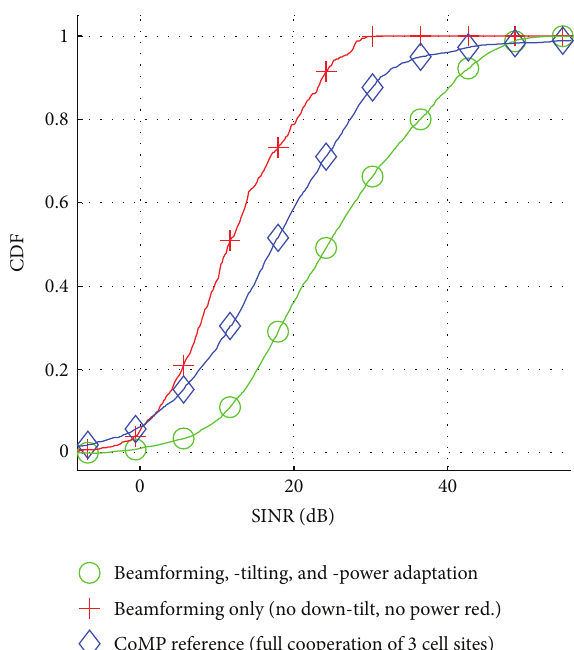
Figure 11: The blue line (diamonds) is the reference scenario as in Figure 5. Red (crosses) denotes the wide band (WB) beamforming switched on, but without any additional downtilt or power adapta- tion. Green (circles) contains the results for additional downtilt and power